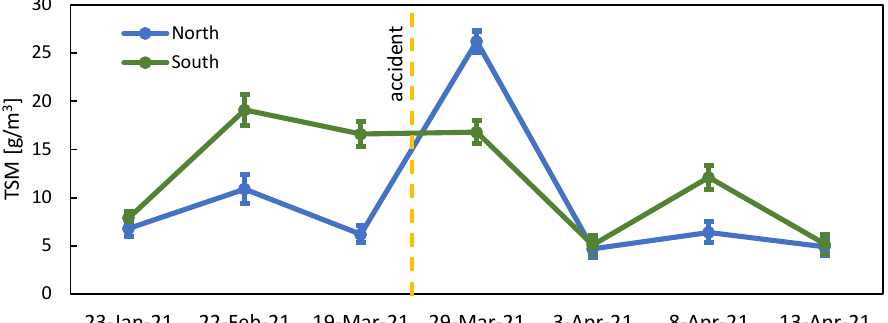
Figure 3. The average concentration of TSM north and south of the location of the stuck ship over the investigated period. The bars show the standard deviation of TSM concentration.